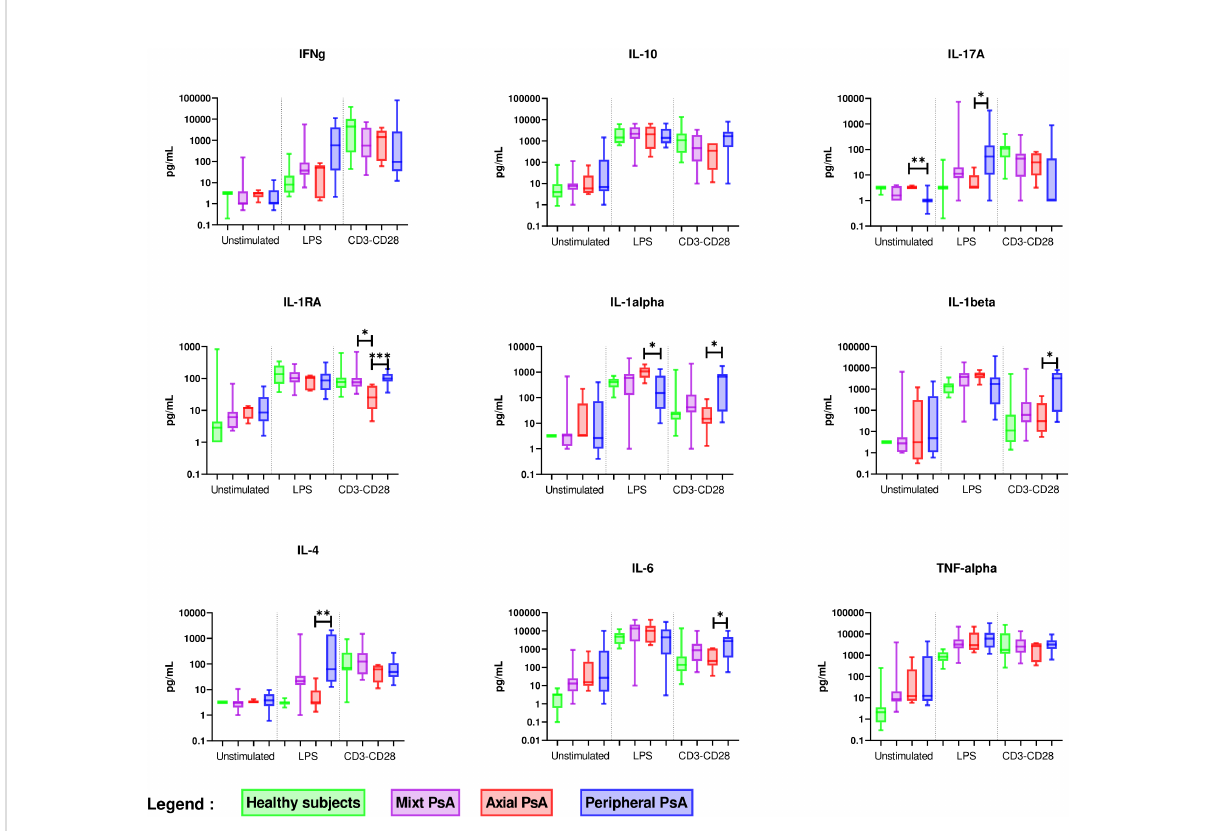
FIGURE 4 Comparison of ex vivo cytokine production between axial (n = 6), peripheral (n = 14) and mixed PsA (n = 17). PBMCs from axial (n = 6), peripheral (n = 14) and mixed PsA (n = 17) patients were cultured at 1x10 6 cells/ml for 24 h at 37°C, 5% CO 2 with and without stimulation of monocytes by E. coli LPS (1 µg/mL) or T lymphocytes by anti-CD3/CD28 mAb (2.5 × 10 4 beads/10 6 cells/ml). Supernatants were collected and cytokine levels were assayed by Luminex Multiplex ELISA. Results are presented using median values with minimum to maximum box-plot. Difference between the groups using non parametric Kruskal-Wallis test with Dunn ’ s multiple comparison test is presented in the top of the fi gure for each condition. * p < 0.05; ** p < 0.01; *** p <